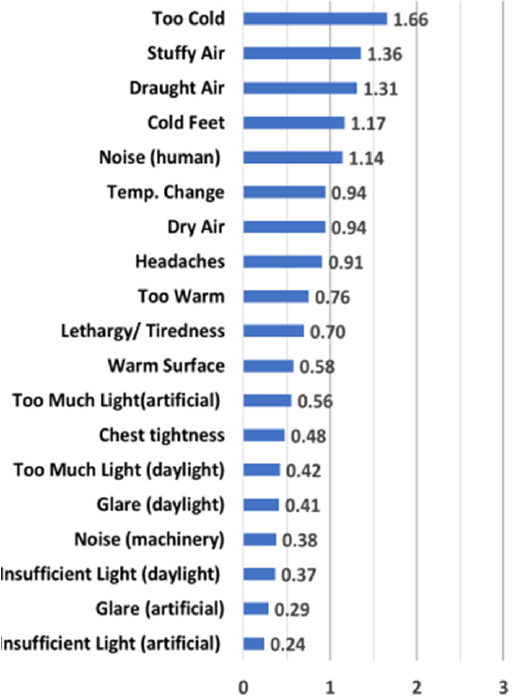
Figure 9. Sensitivity analysis of most common health-related symptoms caused by the Indoor Environment Quality.